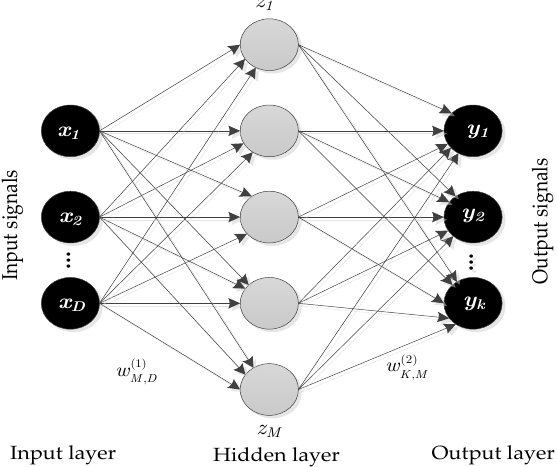
Figure 1. Feedforward neural network (FFNN). The circles represent network layers and the solid lines represent weighted connections. Note that bias weights are not shown in the figure for clarification. The arrows show the direction of forward propagation.